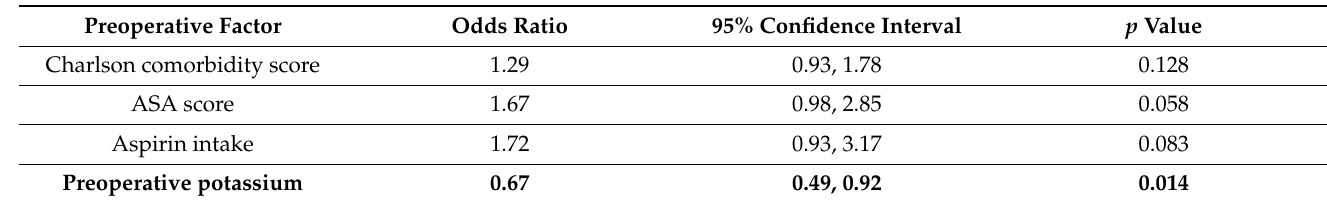
Table 3. Multivariate logistic regression analysis to identify preoperative factors that predict the presence of three or more complications after radical cystectomy. Statistically significant results are marked in bold.